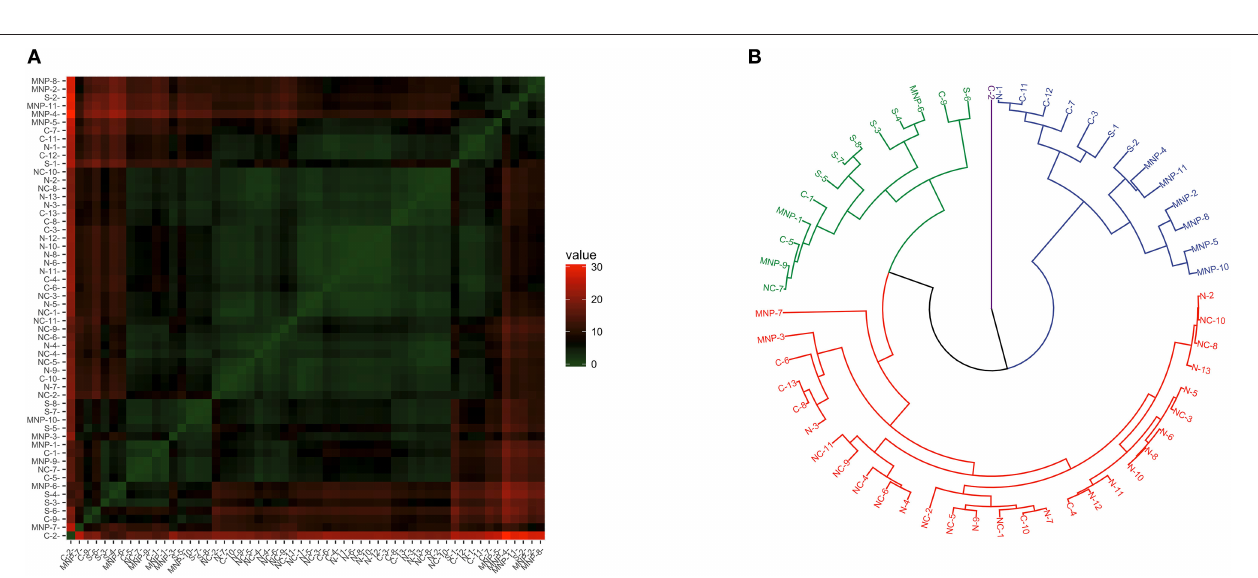
FIGURE 5 | Similarity of Th1/Th2 profile ( GATA3 and Tbx21 gene expression) in blood of California sea lions. (A) Heatmap shows similarity clustering of the gene profiles. Green indicates low dissimilarity and red indicates high dissimilarity in relative transcription levels of the six genes. (B) Dendrogram of gene transcription profile clustering. The tree was built using an Euclidean algorithm. S, South; C, Central; NC, North-Central (Midriff); N, North; MNP, Mexican North Pacific.